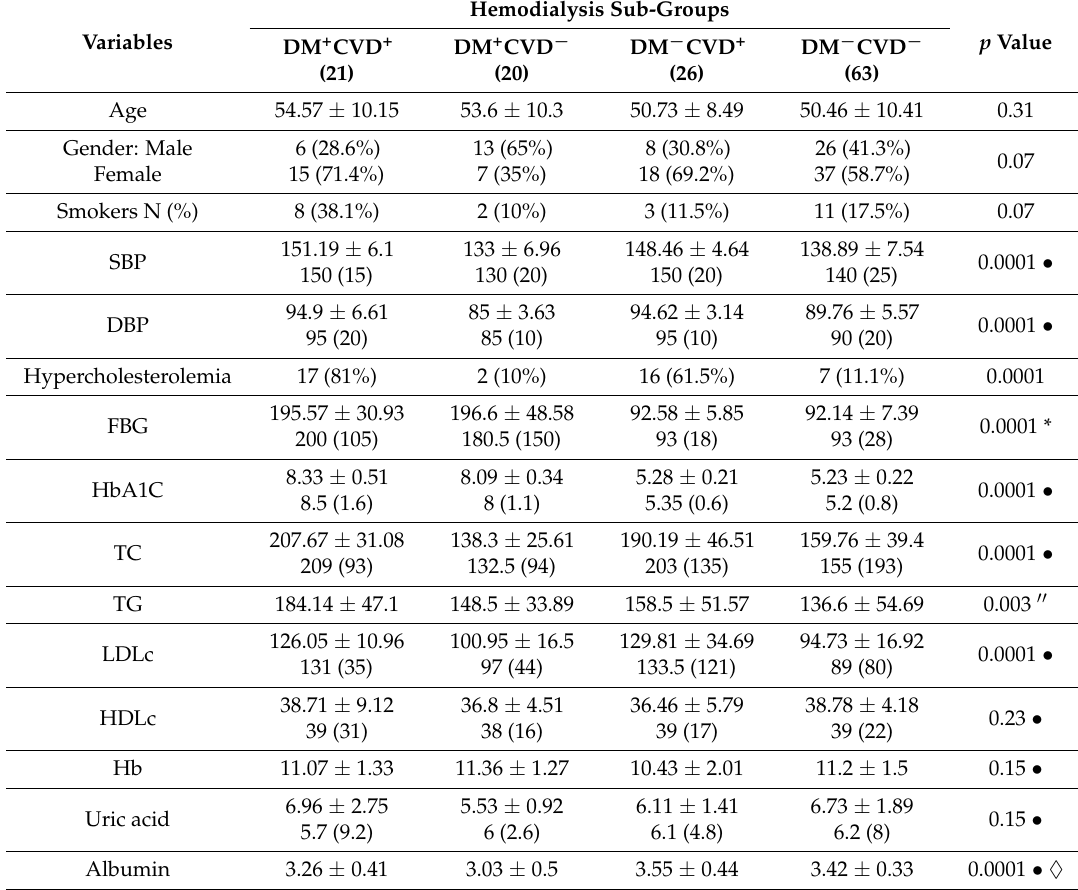
Table 2. Comparison of demographic and clinical data among hemodialysis